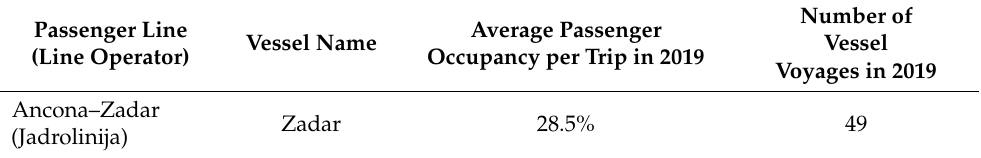
Table 9. Passenger lines serviced in 2019 for the existing Ancona–Zadar route.